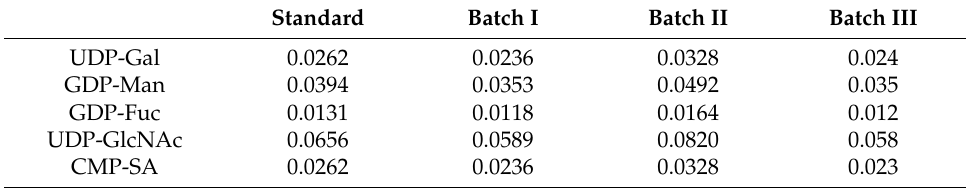
Table 2. Influx values of the nucleotide sugars being synthesized (fmol / cell / day).